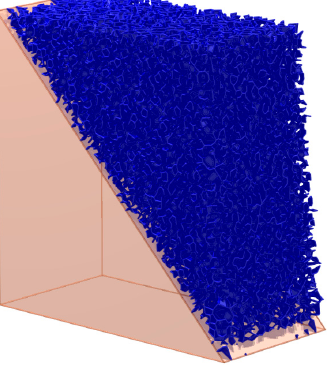
Figure 15. The mesoscopic cracks in State 1.